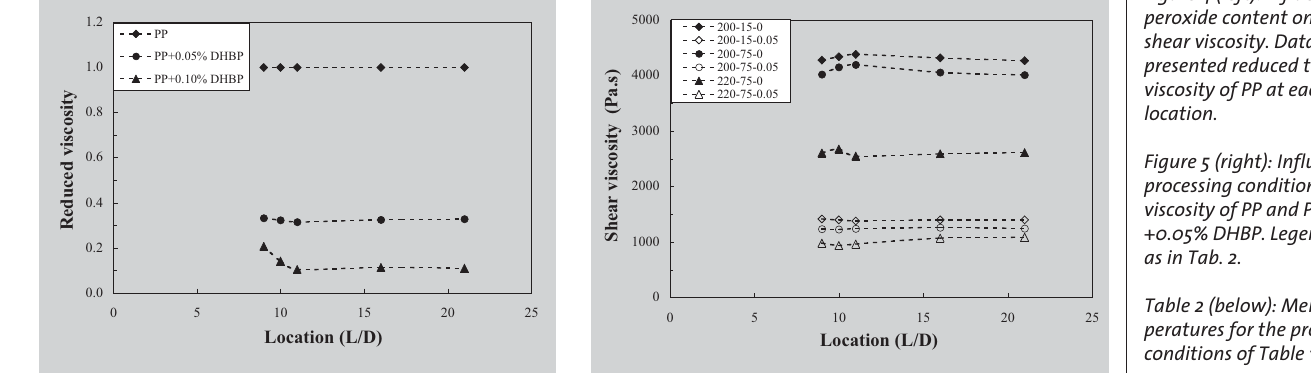
Figure 4 (left): Influence of peroxide content on the shear viscosity. Data is presented reduced to the viscosity of PP at each location. Figure 5 (right): Influence of processing conditions on the viscosity of PP and PP +0.05% DHBP. Legends are as in Tab. 2. Table 2 (below): Melt tem- peratures for the processing conditions of Table